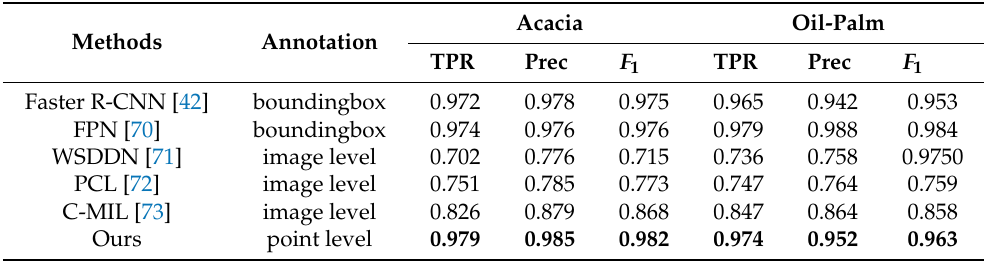
Table 3. The tree localization performance compared with Faster R-CNN, FPN, WSDDN, PCL, and C-MIL on acacia and oil-palm datasets.